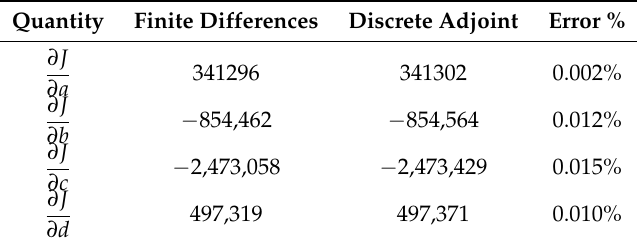
Table A1. Gradients from finite differences vs. gradients from the discrete adjoint for the baseline geometry.